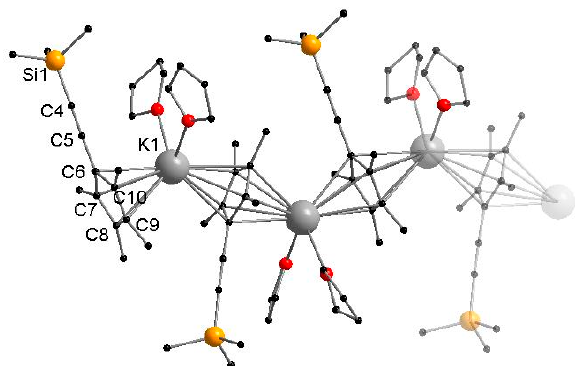
Figure 2. Cutout of the molecular structure of 2 in the solid state. Hydrogen atoms are omitted for clarity. Selected bond lengths [Å] and angles [°]: K1–C6 3.075(3), K1–C6’ 3.020(3), K1–C7 3.020(3), K1–C7’ 3.103(3), K1–C8 3.054(3), K1–C8’ 3.070(3), K1–C9 3.002(3), K1–C9’ 3.054(3), K1–C10 3.036(3), K1– C10’ 3.011(3), C4–C5 1.212(5), K1–O1 2.796(3), K1–O2 2.720(2), CpMe 4 (C ≡ CSiMe 3 )-Centroid–K1–CpMe 4 (C ≡ CSiMe 3 )-Centroid 133.33(1), O1–K1–O2 90.20(8).